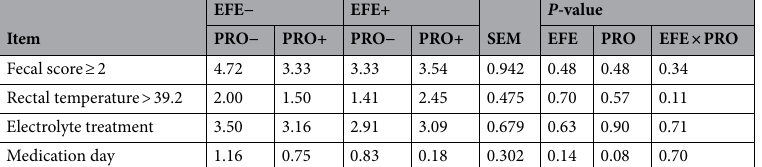
Table 4. Least squares means for health status in dairy calves supplemented with or without exogenous fibrolytic enzymes (EFE) and probiotic (PRO) in the starter diets (n = 12 calves per treatment). Treatments were (1) calves fed diets without exogenous fibrolytic enzymes (EFE)-treated wheat straw and probiotic supplement (EFE-Pro−), (2) calves fed diets of EFE-treated wheat straw but with probiotic supplement (2 g/d/calf; EFE-Pro+), (3) calves fed EFE-treated wheat straw (2 g/d/calf) but without probiotic supplement (EFE+ Pro−), (4) calves fed EFE-treated wheat straw and probiotic supplement (EFE+ Pro+). Exogenous fibrolytic enzymes were applied to wheat